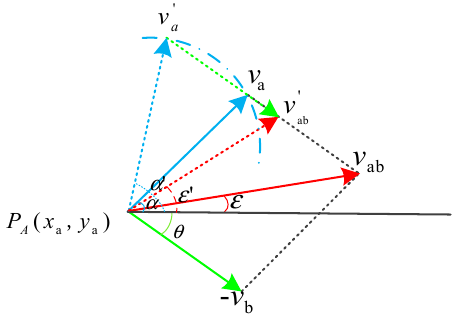
Figure 5. UAV of the change in speed before and after the release of the UAV’s heading. The blue dashed line in the figure indicates the direction of the velocity of the